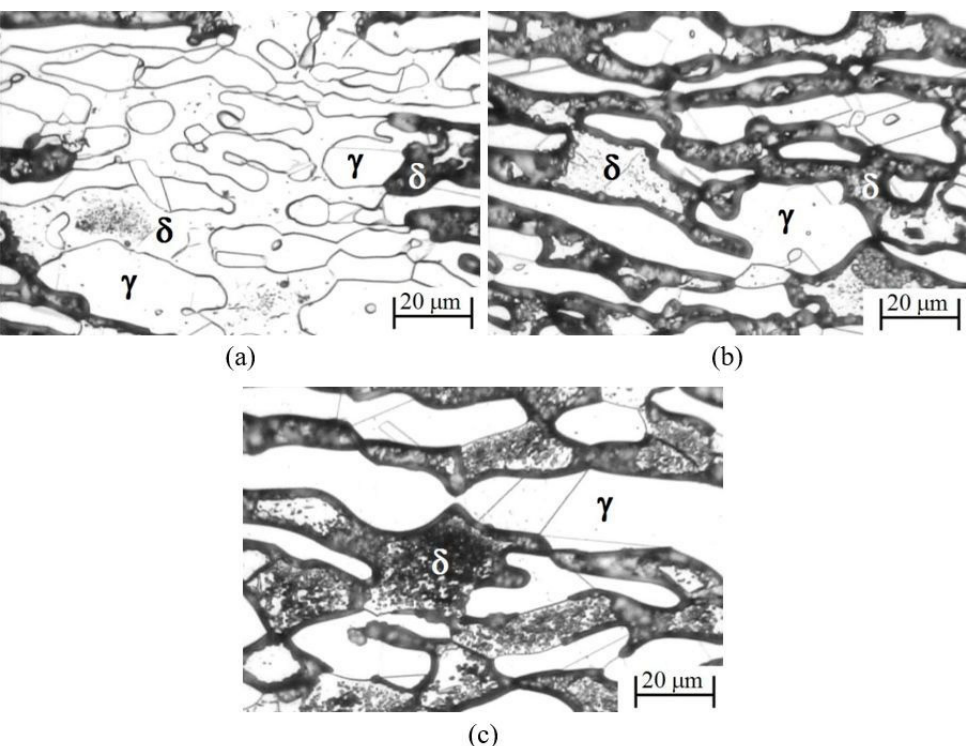
Figure 3. Specimens etched with 10% acid oxalic solution (9.0 V, 60 s): (a) ST-1050; (b) ST-1100; (c)